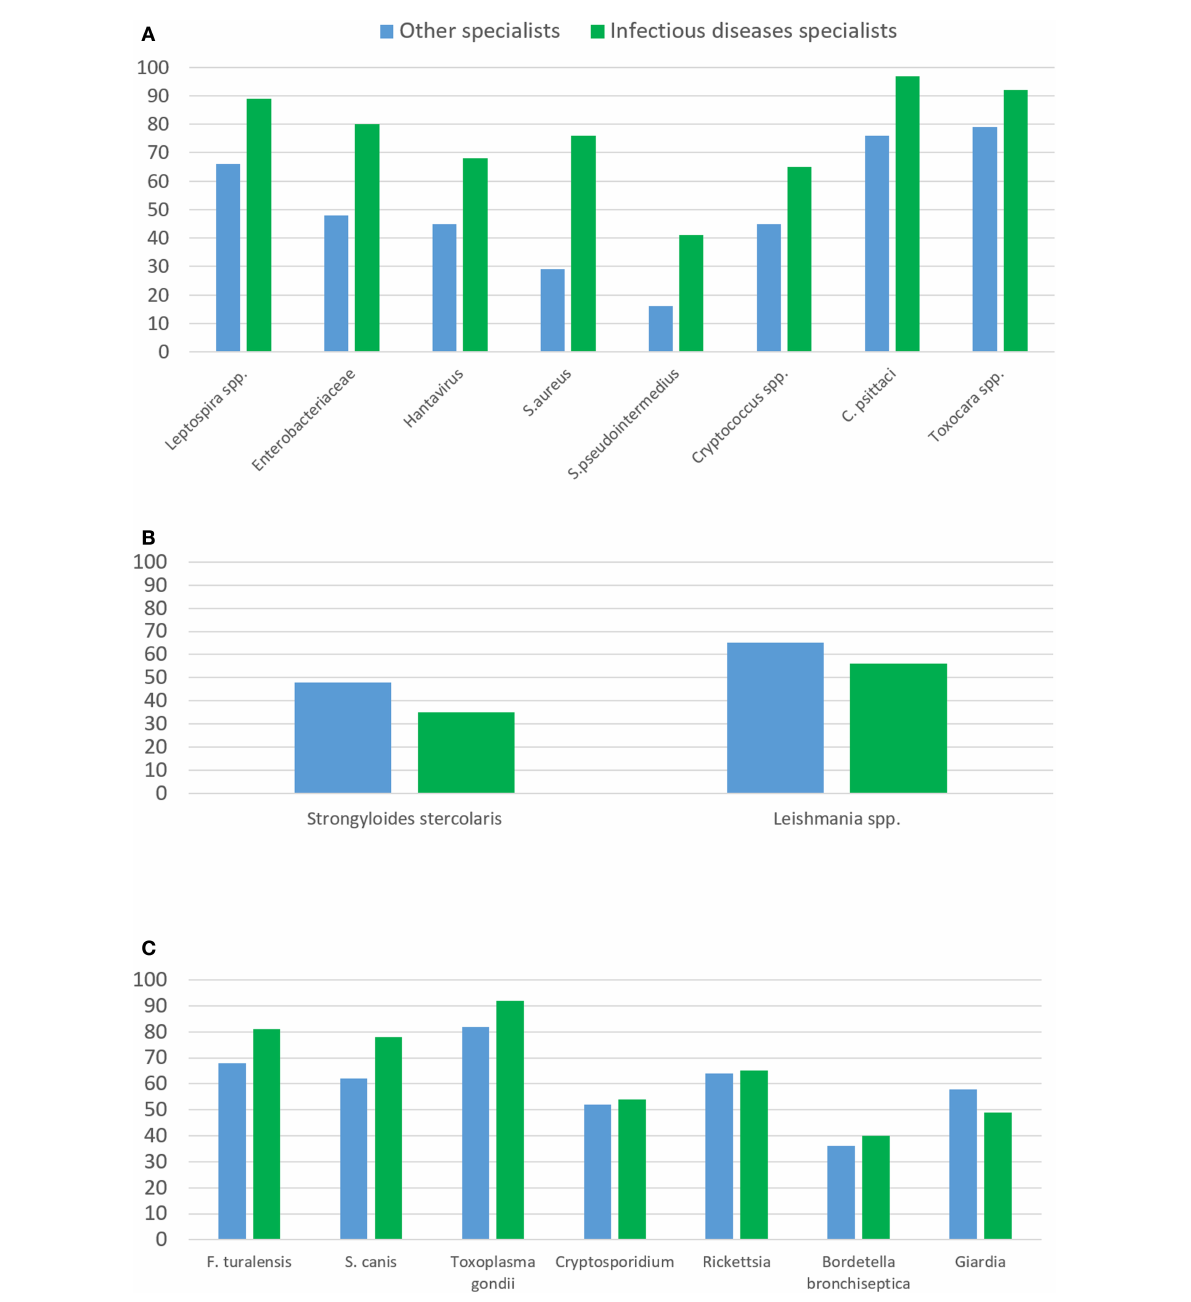
FIGURE2 Differences in the identification of pathogens according to the type of medical specialist. (A) Zoonotic pathogens significantly identified more frequently by the infectious disease specialists than by the other specialists ( p < 0.05). Enterobacteriaceae include Campylobacter, E. coli and Salmonella. Atypical mycobacteria and Microsporidium canis were also more frequently identified by infectious diseases specialists (57 vs. 76% and 63 vs. 78%, respectively); (B) Zoonotic pathogens significantly identified more frequently by the other specialists than by the infectious disease specialists; ( C) Pathogens with no significant difference in their identification comparing infectious disease specialists with other specialists.